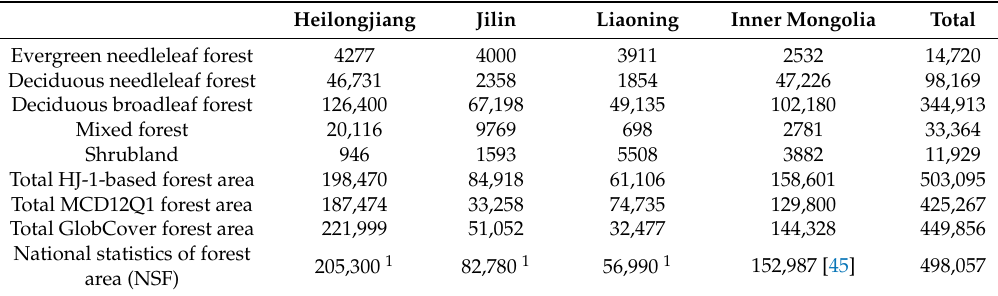
Table 6. Provincial estimates of forest area (km 2 ) from the HJ-1-based map, GlobCover 2009 and MCD12Q1